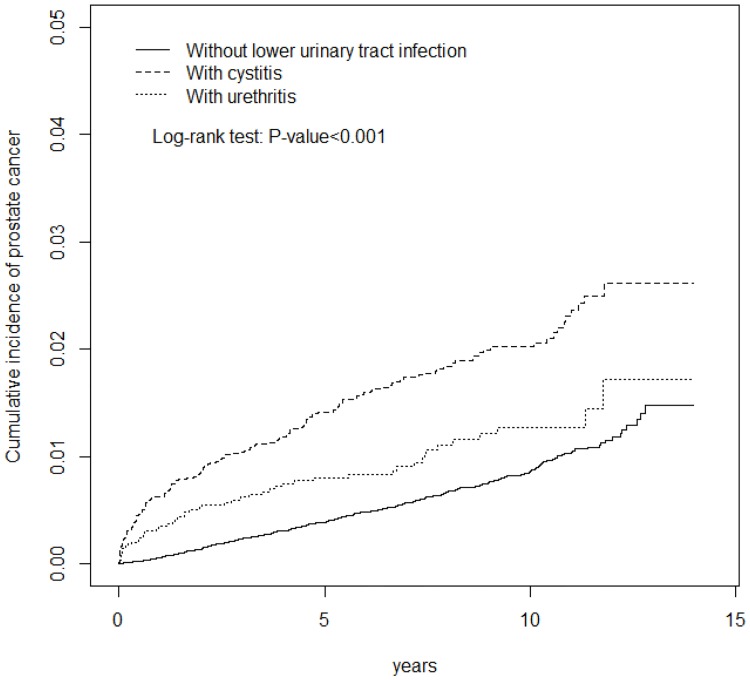
Comparison of the cumulative incidence of prostate cancer (determined by the Kaplan-Meir method) among the cystitis, urethritis and without urinary tract infection cohort groups.